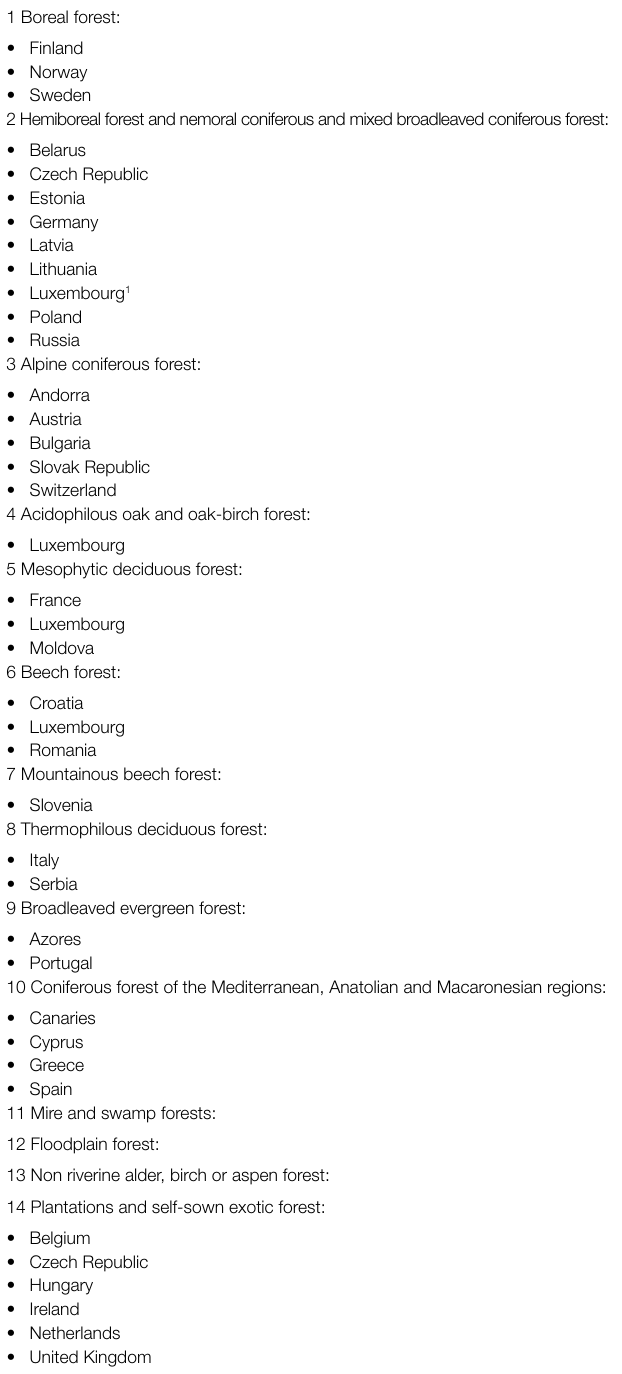
TABLE 8 | EEA Technical report (European Environment Agency, 2007) forest types and countries where they are prototypical. 1 Boreal forest: